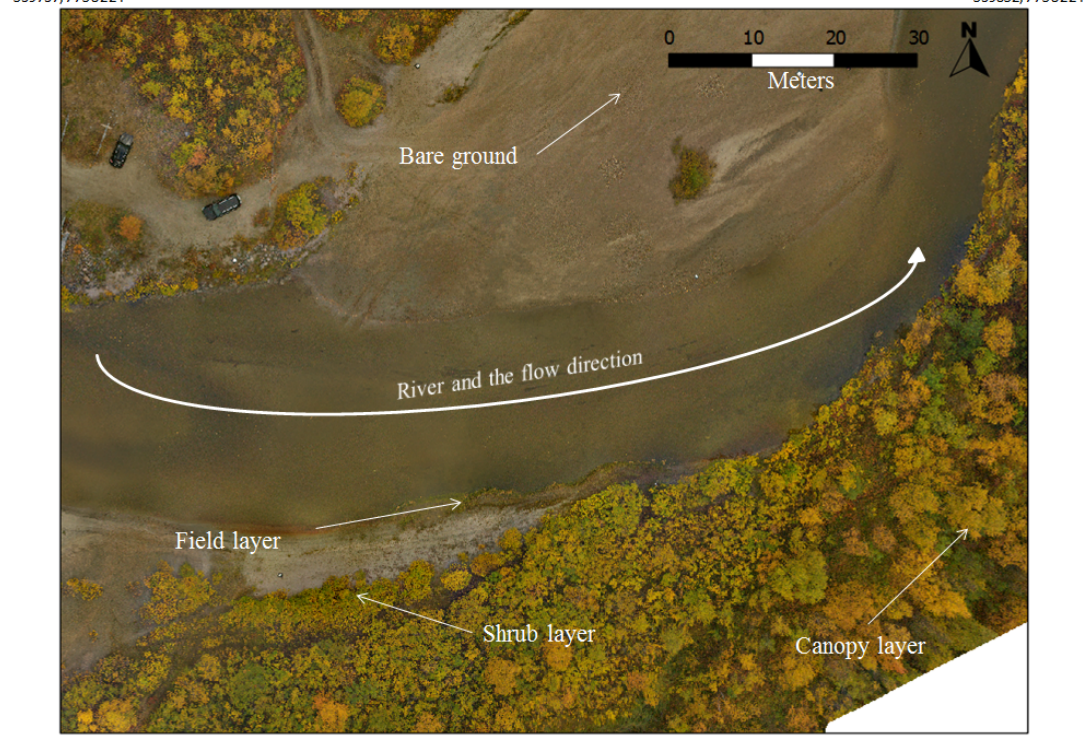
Figure 3. Illustration of vegetation classes selected from aerial images. Note the submerged and dry areas of the meander bend. Coordinates of the corners of the capture are presented in